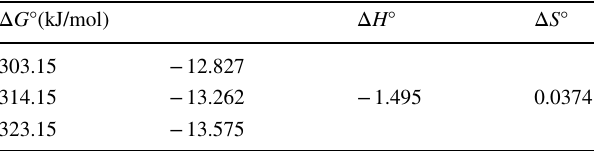
Table 6 Thermodynamic parameters for adsorption of MB onto BNH-CM